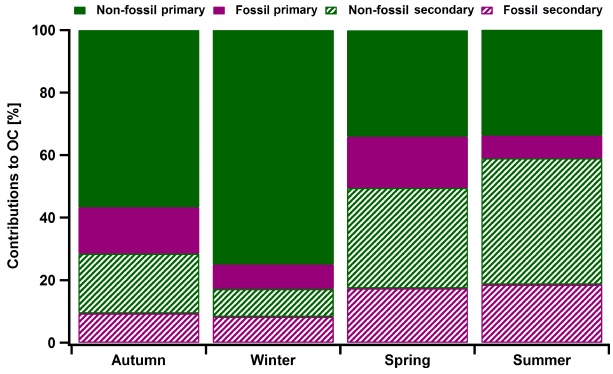
Figure 11. Averaged contributions of the fossil and non-fossil pri- mary and secondary OC to the total OC season wise for PM 10